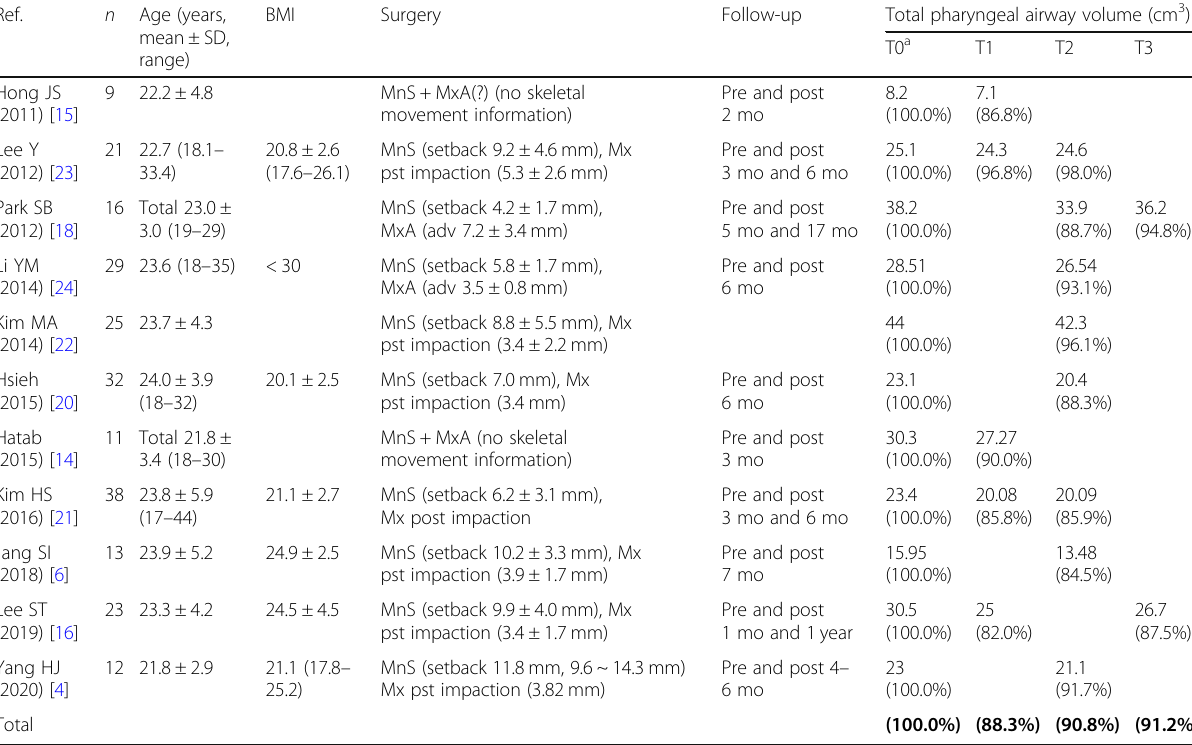
Table 2 Changes in in the total pharyngeal airway volume after two-jaw surgery for mandibular prognathism